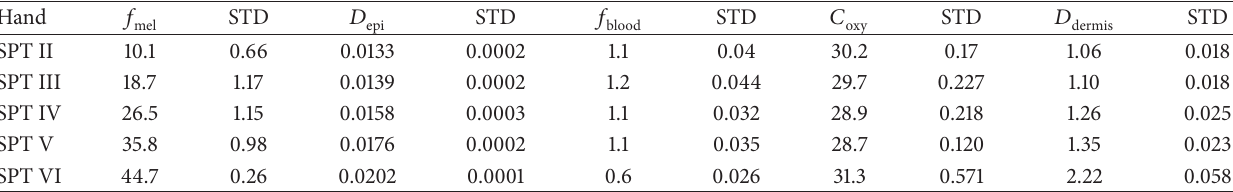
Table 3: Hand parameters estimation for SPT II, III, IV, V, and VI.